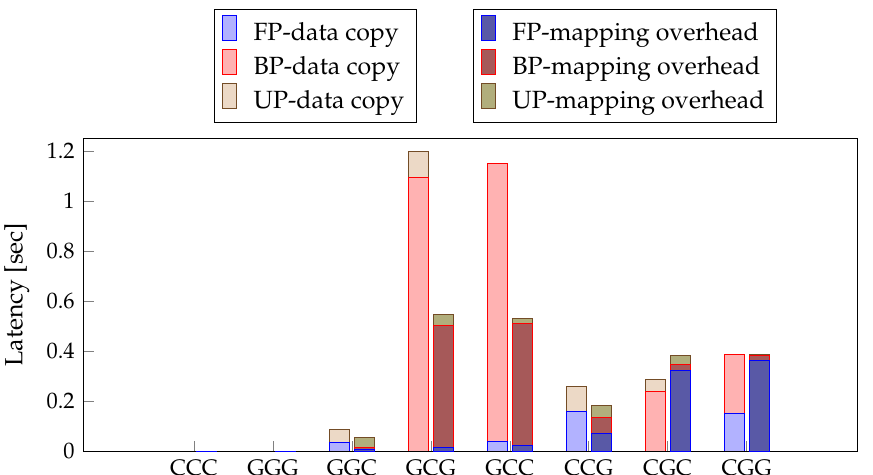
Figure 7. Results of profiling eight cases for data transfer. The three words represent the processor of the FP step, the processor of the BP step, and the processor of the UP step in order. In this study, C means CPU, G means